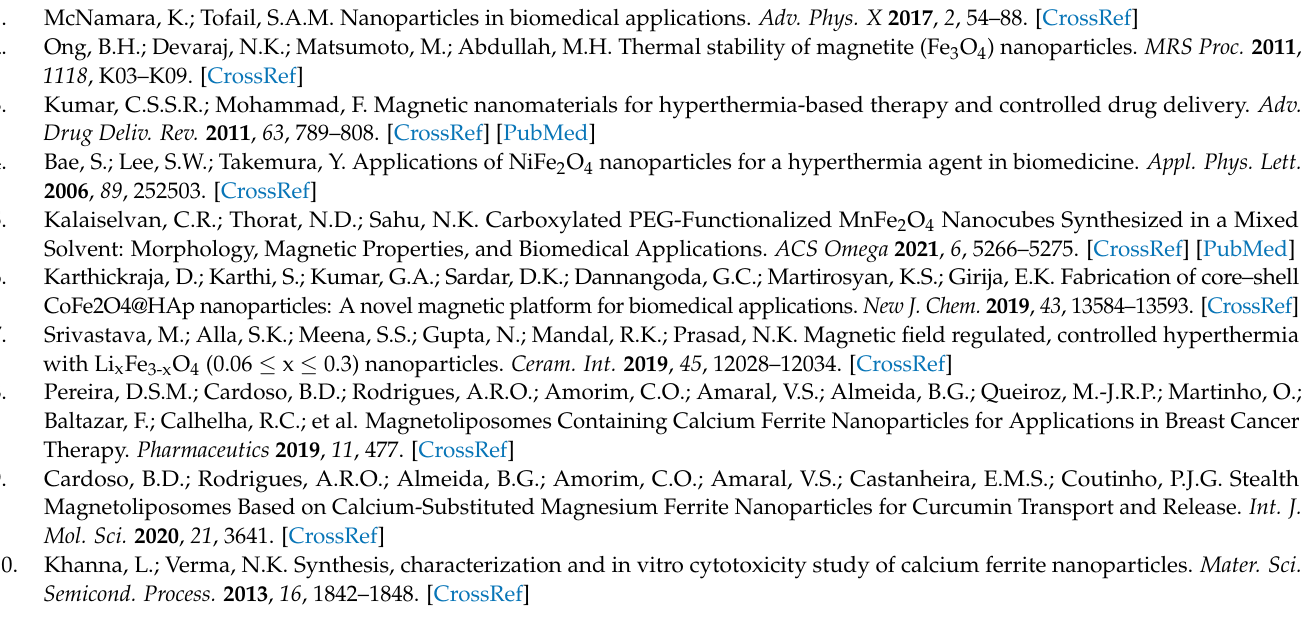
experiments; Figure S8. Cumulative selected area electron diffraction (SAED) pattern for 120